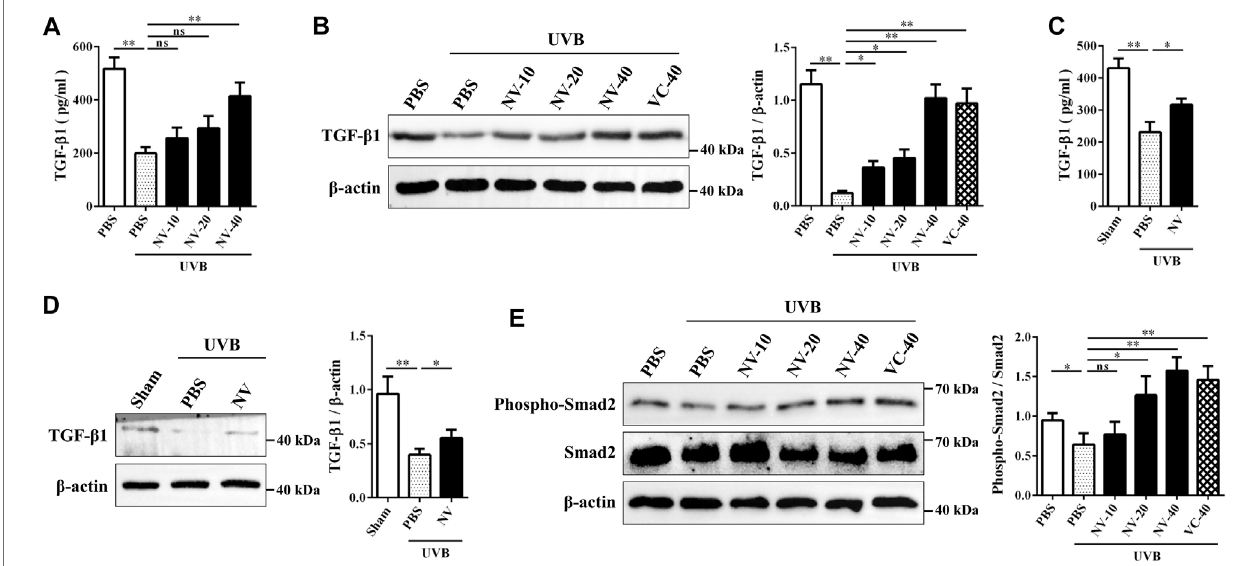
FIGURE10| Antioxidin-NVrestoredTGF- β 1secretionandTGF- β /Smad2signalingpathwayinHSFcells. (A , B): ELISA (A) andWesternblot (B) showedantioxidin- NVsigni fi cantlyincreasedTGF- β 1secretioninHSFcells. (C , D) ELISA (C) andWesternblot (D) showedantioxidin-NVsigni fi cantlyincreasedTGF- β 1secretioninhairless mice skin. (E) Western blot showed effects of antioxidin-NV on TGF- β signaling pathways and relative activation analysis. The results were quanti fi ed by Image J. The densitometry of phosphorylated Smad2 were normalized to Smad2, and graphed as the mean ± SD ( n (cid:1) 3). NV-10, 20, 40, VC-40 indicated the concentrations of 10, 20, 40 μ g/ml respectively. ns, no signi fi cance, * p < 0.05, ** p <